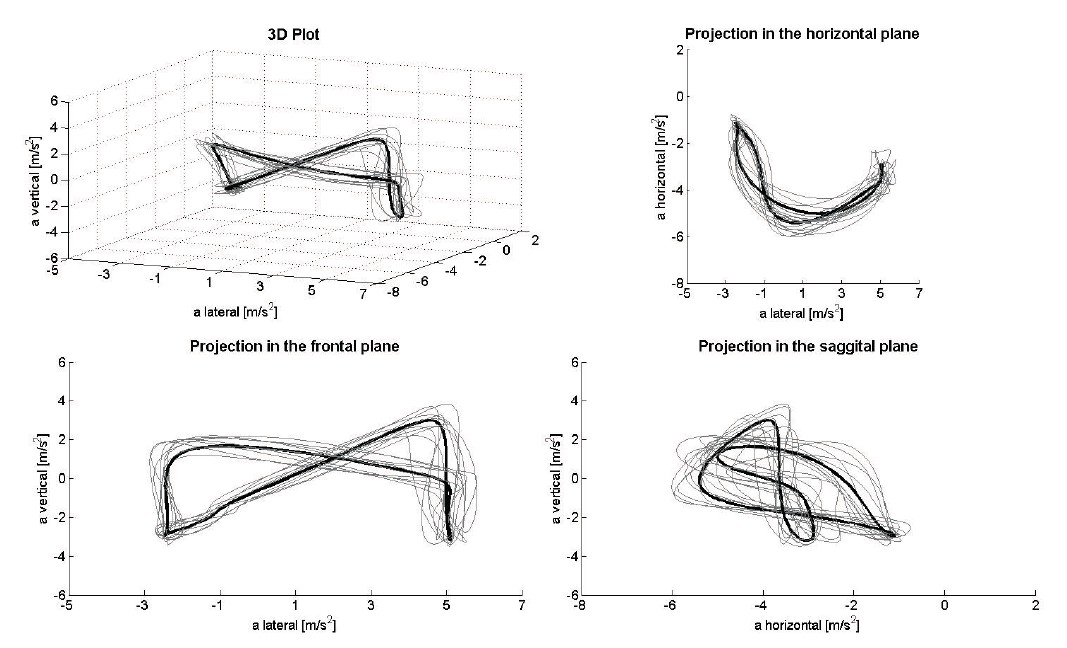
Figure 2. Acceleration data during G2R in the total space ( upper left ) and frontal ( lower left ), horizontal ( upper right ) and sagittal planes ( lower right ).